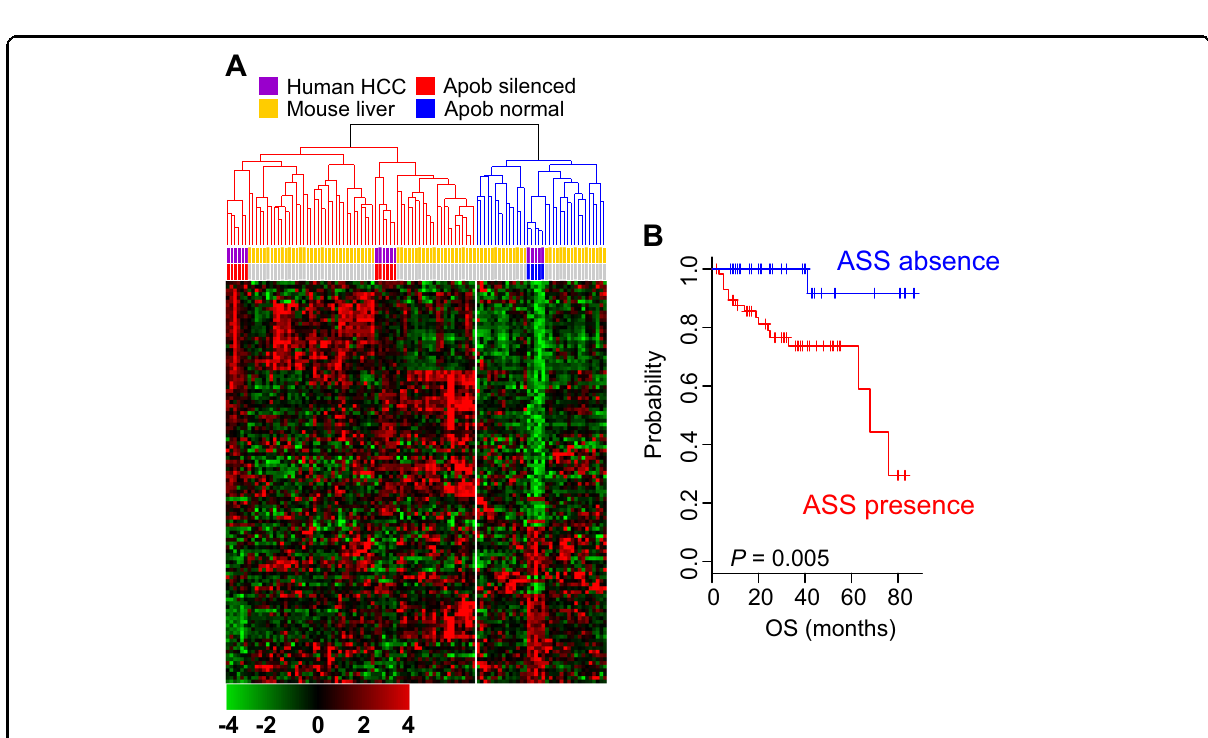
Fig. 2 Clinical relevance of APOB ablation in hepatocellular carcinoma (HCC). a The Apob-silenced signature (ASS) was integrated with gene expression data from human HCC samples (The University of Texas MD Anderson Cancer Center cohort), and clustering was performed. Patients were strati fi ed into two clusters according to their expressional similarity to mouse livers. b Kaplan – Meier plots of HCC patient overall survival (OS) in the MD Anderson Cancer Center cohort. Patients with the ASS had a poorer prognosis (lower OS rates) than those without the